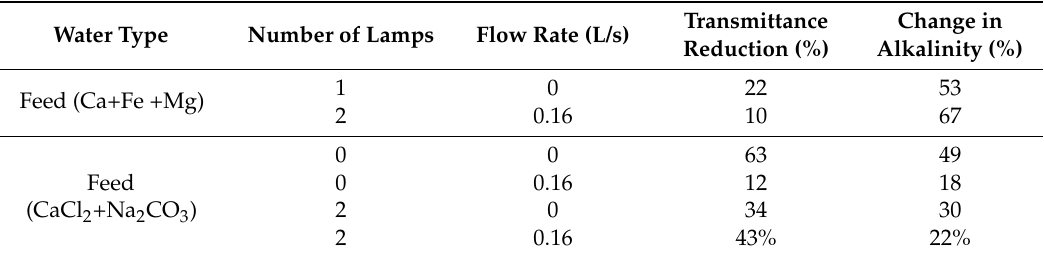
Table 4. Reduction in transmittance and change in alkalinity due to hard water over 96 h operating at an initial UV dose greater than 120 mJ/cm 2 and a UVT of 98%.